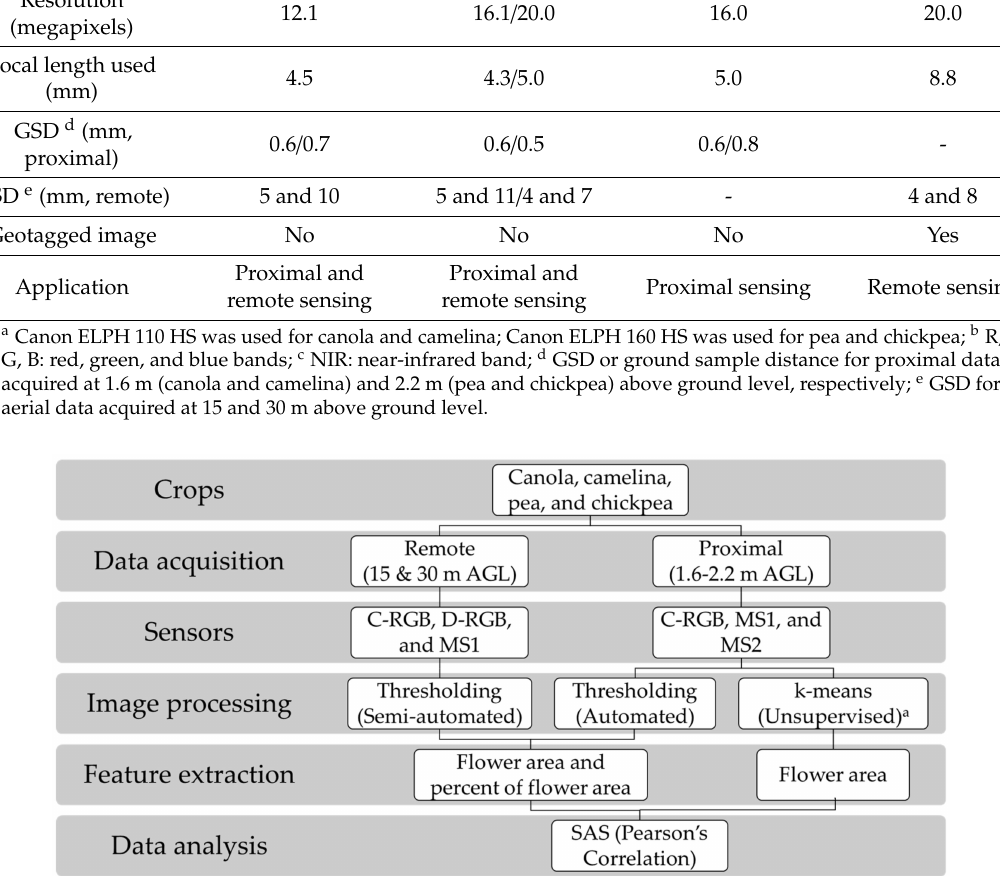
Figure 1. Workflow of monitoring flowering intensity in cool-season crops using sensing techniques. AGL: above ground level; C-RGB camera: canon digital / RGB camera (PowerShot SX260 HS); D-RGB: RGB camera of DJI Phantom 4 Pro; MS1 and MS2 cameras: modified digital cameras with one